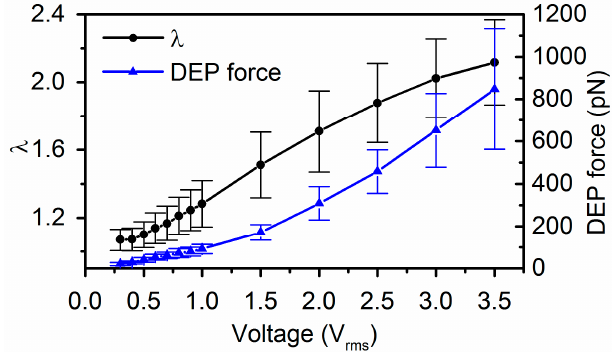
Figure 4. Electrodeformation of RBCs ( n = 84) with estimated DEP force magnitude and the corresponding extension ratio, λ as functions of applied voltage levels. Error bar indicates standard deviations.